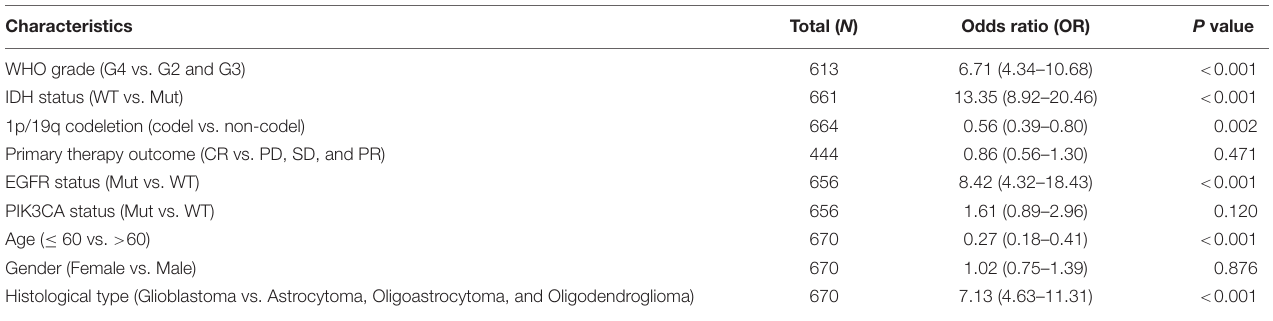
TABLE 2 | IER5 expression associated with clinical pathological characteristics (logistic